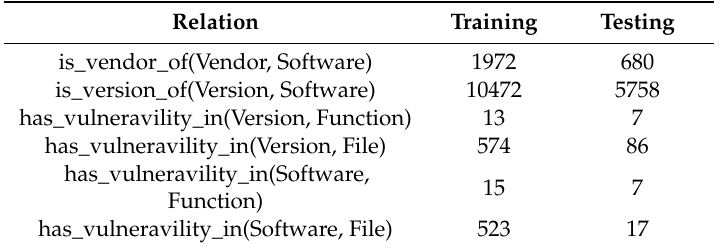
Table 2. Relation extraction (RE) corpus